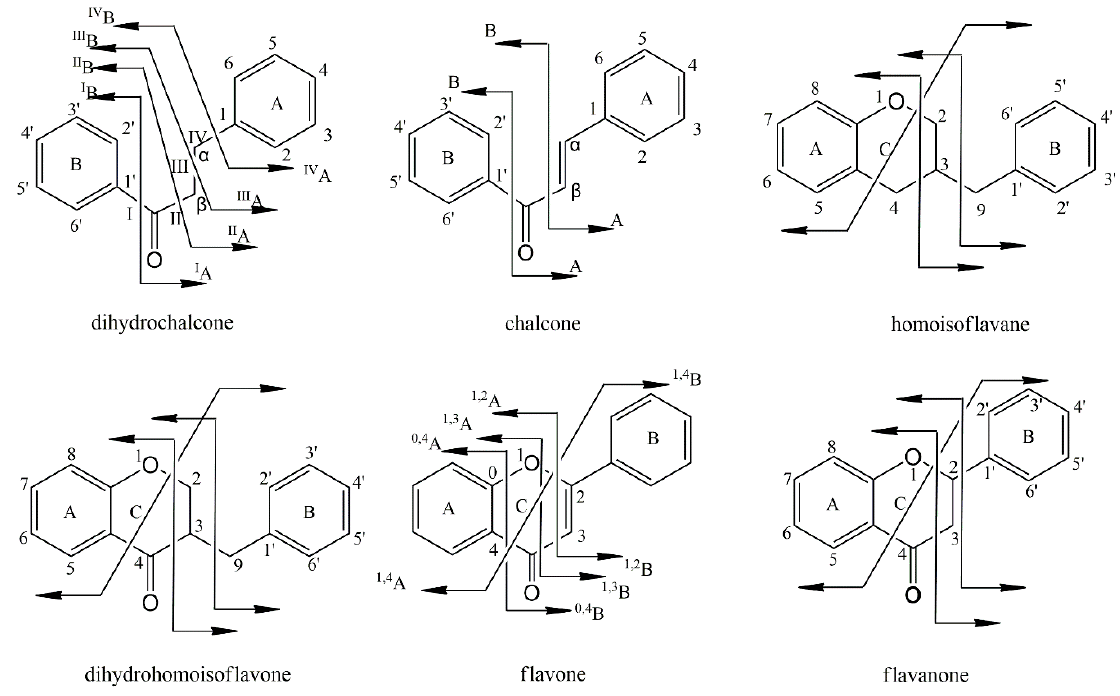
Figure 3. Fragmentation pathway of flavonoid compounds in Resina Draconis.